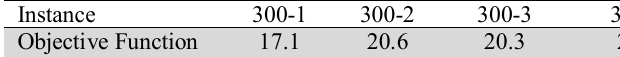
Results of relaxed model with large instances Instance 300-1 Objective